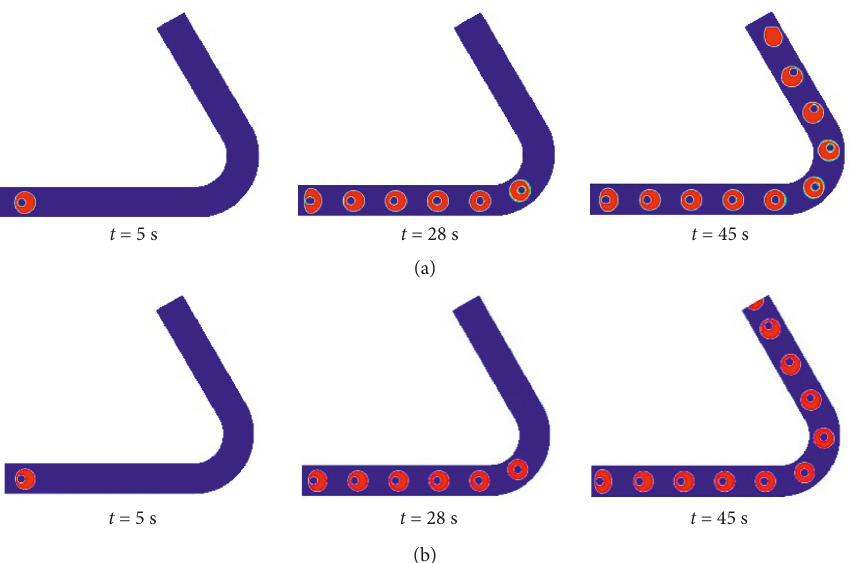
Figure 7: Effect of capillary number of continuous phase on the interface shape during compound droplet deformation: (a) Ca � 0.05; (b) Ca �